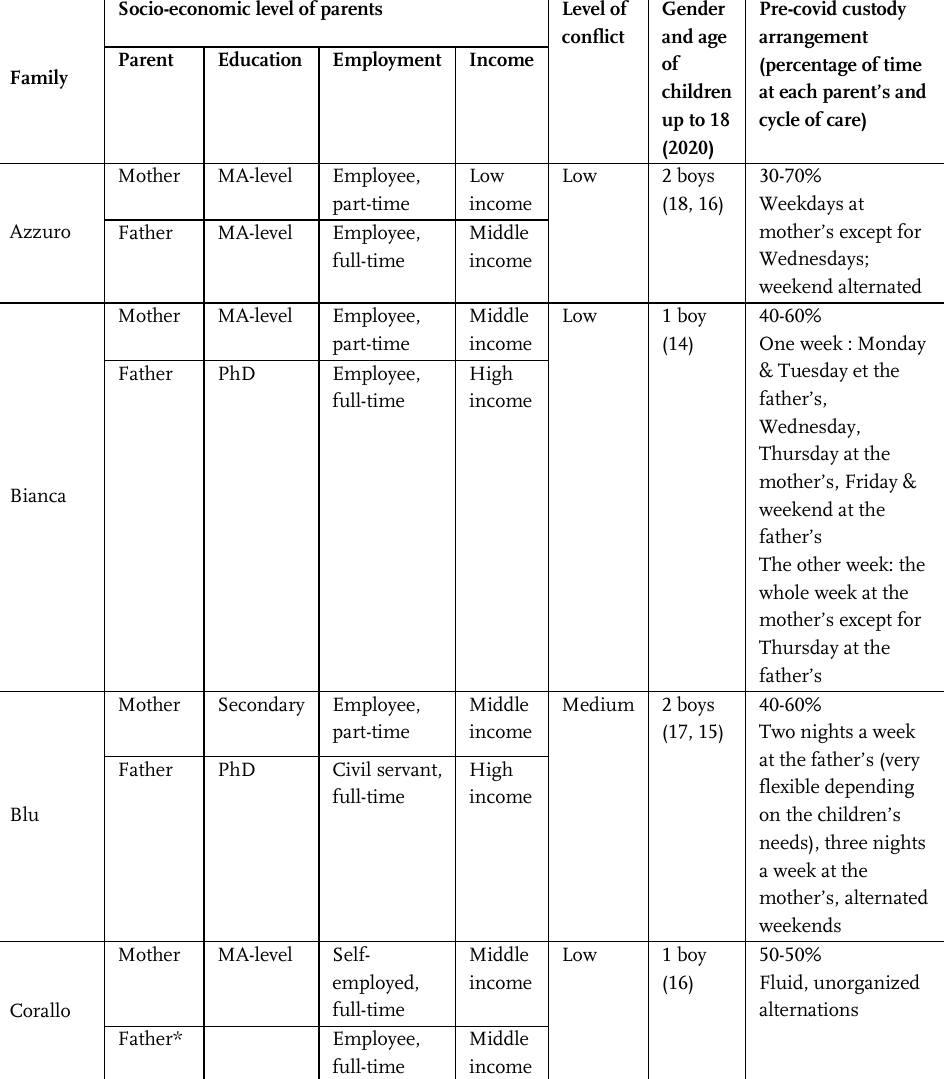
Table 1: Family profiles and custody arrangements before Lockdown (continued)